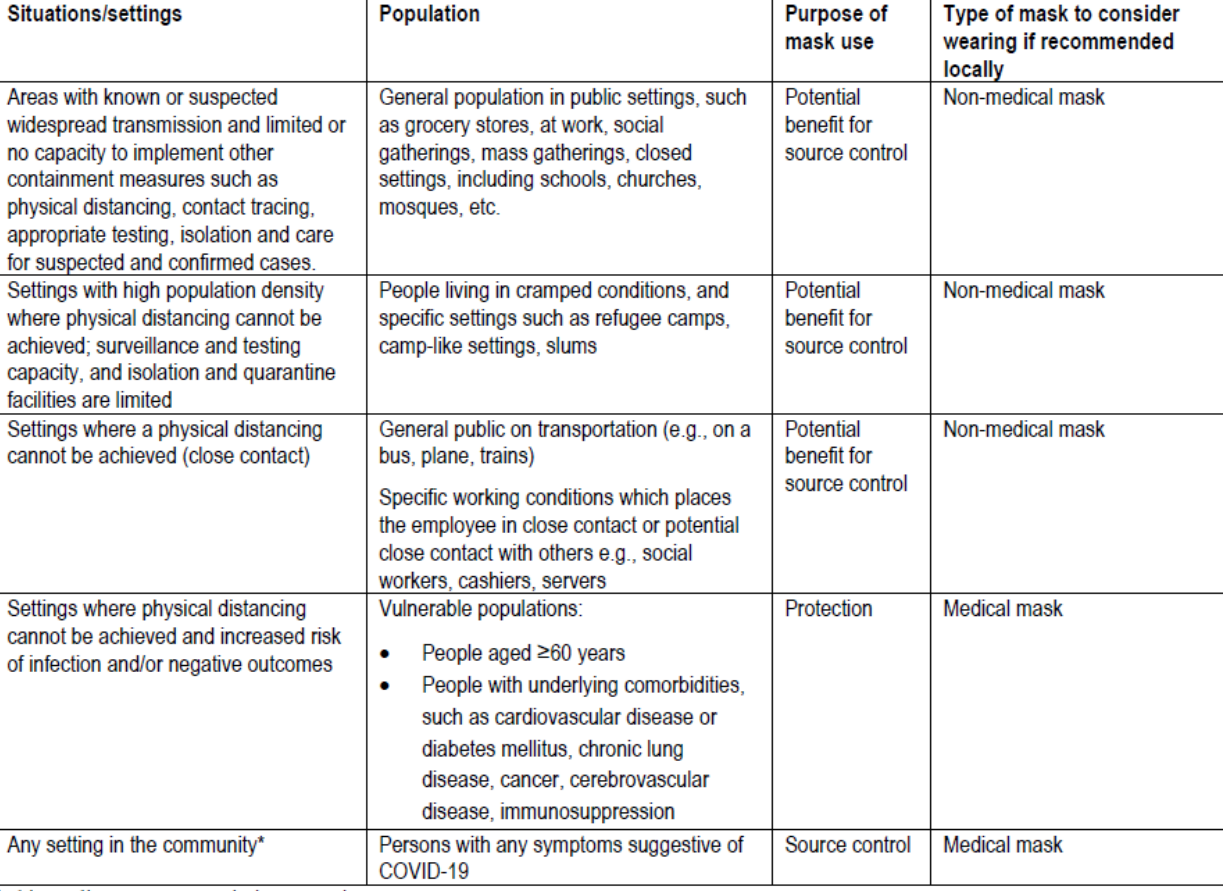
Table 1: Situations and types of masks recommended for use in the community (from the World Health Organization, June 2020 interim guidance “Advise on the use of masks in the context of